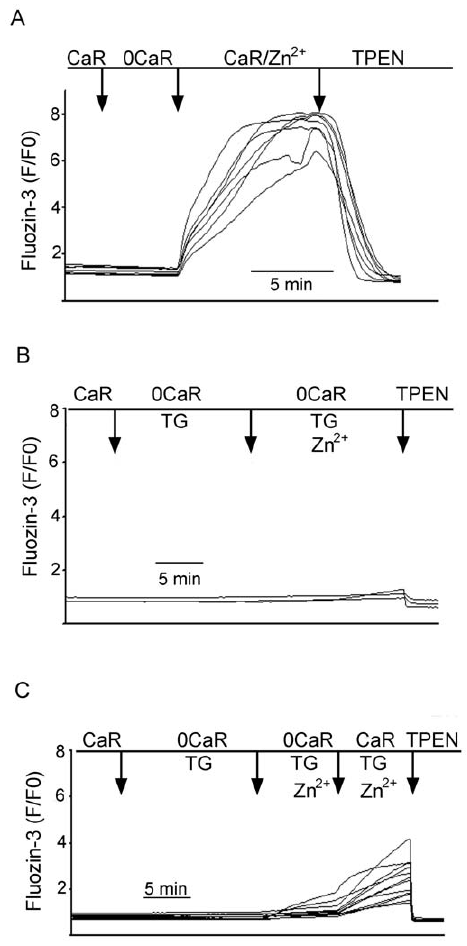
Figure 4. Recordings from imaging studies in individual isolated gastric glands of [Zn2 + ]I during deprivation and restoration of Ca 2 + . Panel 4A: A single gland with 7 parietal cells imaged, exposed first to Ringer’s solution {Ca 2 + 1 mM, no added Zn 2 + }, then Ringer’s solutions depleted of Ca 2 + but containing Zn 2 + 10 m M, then Ringer’s solutions containing both 1 mM Ca 2 + and 10 m M Zn 2 + . Recording is terminated with addition of TPEN to confirm that signals are due to Zn 2 + . Note variable responses in individual cells. In 15 of 17 studies (88%), loading of Zn 2 + was observed in the presence of Ca 2 + . Among the 15 glands responding, the mean increase over baseline was 157% + 3% (P , 0.0001). Panel 4B: A single gland cell (3 cells), exposed initially to thapsigargin (2 m M) and Ca 2 + -depleted Ringer’s solution, then to Ringer’s containing thapsigargin and 10 m M Zn 2 + in the absence of Ca 2 + . In 49 glands (3–8 cell per gland), no loading response to 10 m M Zn 2 + was observed in the absence of extracellular Ca 2 + , more than 3% above baseline. PANEL 4C . A single gland (12 cells) exposed to initial conditions similar to those in Panel 2B, but with 1 mM Ca 2 + present. Among 24 glands, the mean response was 60% + 1% over baseline. In each recording, the experiment is terminated with addition of TPEN to confirm that signals are due to Zn 2 + . These findings indicate that extracellular Ca 2 + partially restores Zn 2 + loading and that uptake of Zn 2 + across the basolateral membrane of the parietal cell is regulated by [Ca 2 + ] i .